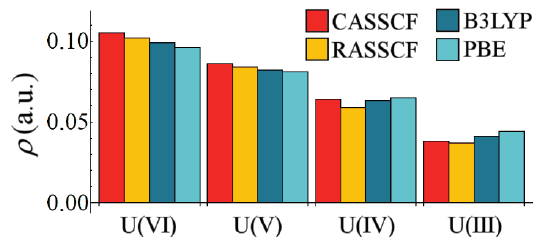
Figure 2. Variation of (cid:2025) at the U–Cl bond critical point as a function of oxidation state.